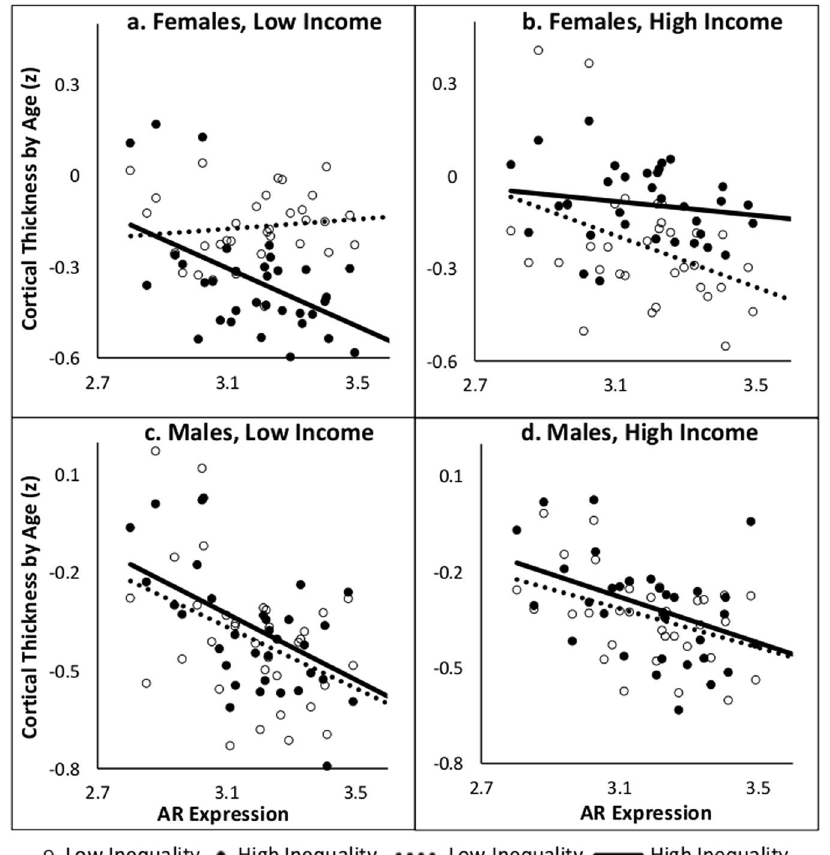
Figure 3. The y-axis (Cortical Thickness by Age) is the Fisher z-transformed correlation coefficients of cortical thickness and age in each of the 34 regions. The x-axis is the AR expression in each of these regions. For each subgroup, there are 34 points representing each cortical region. Each male and female income subgroups are divided into high (solid circle, solid line) and low (hollow circle, dashed line) inequality subgroups. An inequality by AR expression interaction was analyzed for each income